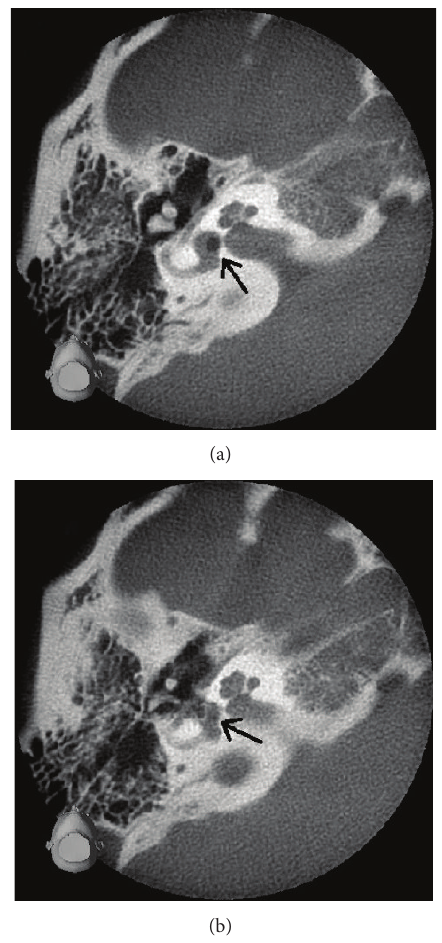
Figure 2: Axial views of the right ear on cone-beam computed tomography on hospital on day 1, showing a round low density area (a) and intrusion of stapes (b) (black